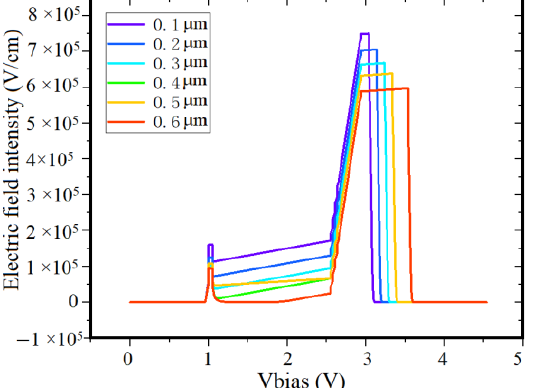
Figure 8. The electric field distribution of the device varies with the multiplication layer thickness under breakdown bias.